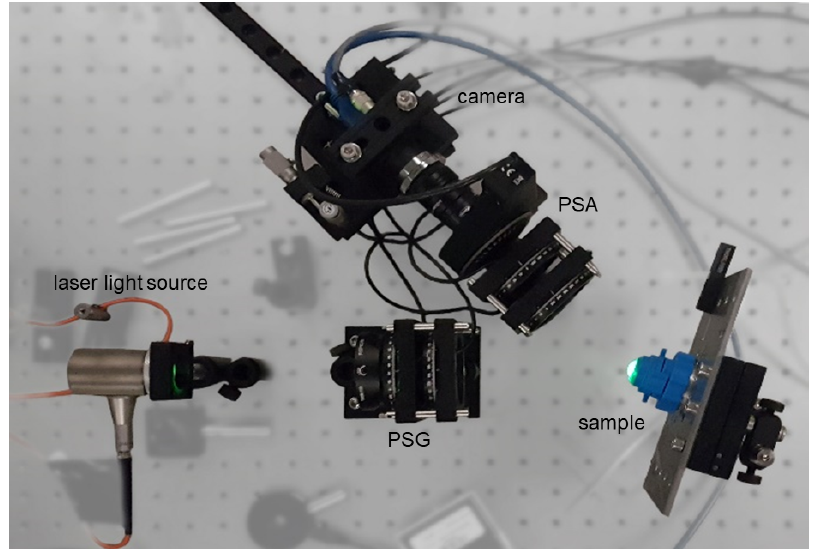
Figure 3. Photograph of the setup for MM measurements of porcine corneas in reflection mode. Since the cornea has a curved surface, the sample cannot be aligned in parallel to the illumination beam. Reproduced from [38].